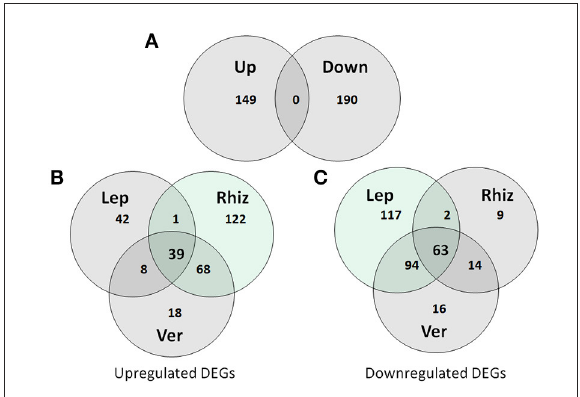
FIGURE3 (A) Total distribution of up- and downregulated genes (DEGs) in the treatments of S. plymuthica HRO-C48 with fungal VOCs. Up- (B) and down- (C) regulation of the genes in S. plymuthica HRO-C48 due to the contact with the VOCs of R. solani AG2 (Rhiz), L. maculans MB 158 (Lep) and V. longisporum ELV 43 (Ver). The numbers in the circles indicate the number of DEGs due to the contact with the volatiles of each fungal strain. The light green color indicates the treatment resulting in the highest amount of the up- or downregulated transcripts among the three conditions